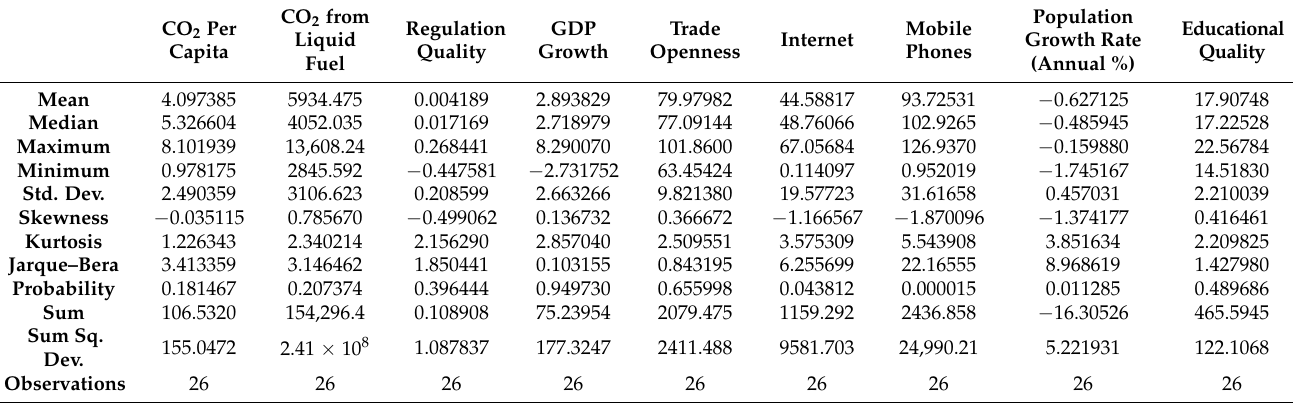
Table 2. Descriptive